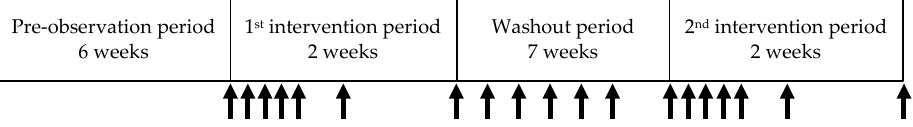
Figure 2. Trial design. Faecal sample collection is indicated with arrows.